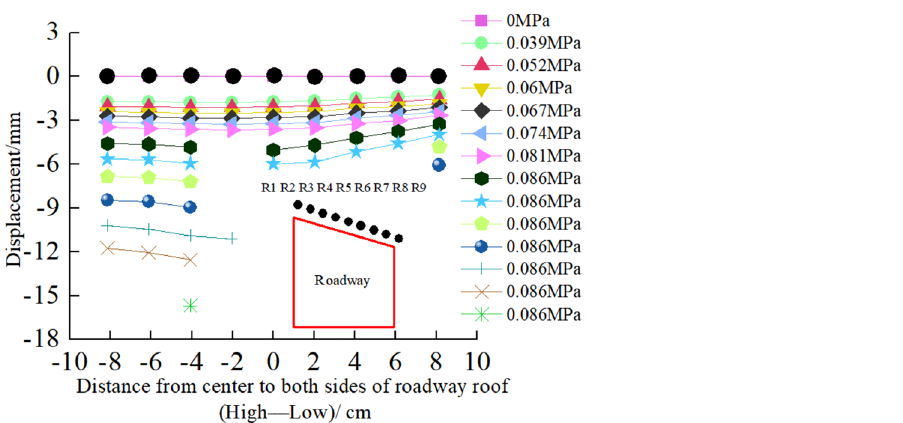
Figure 9. Evolution of surrounding rock separation layer on shallow surface of roadway roof with